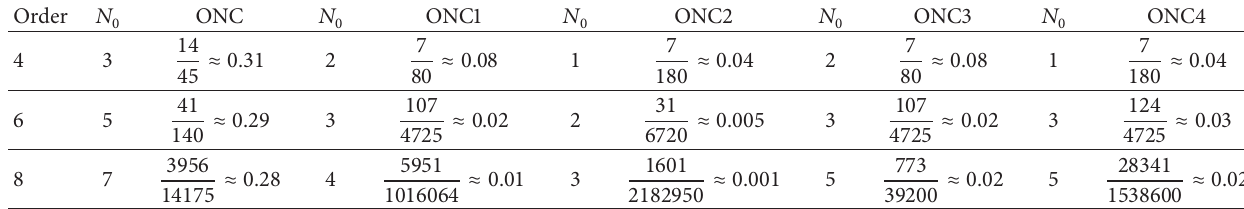
Table 1: Coefficients of error term for each order of accuracy.